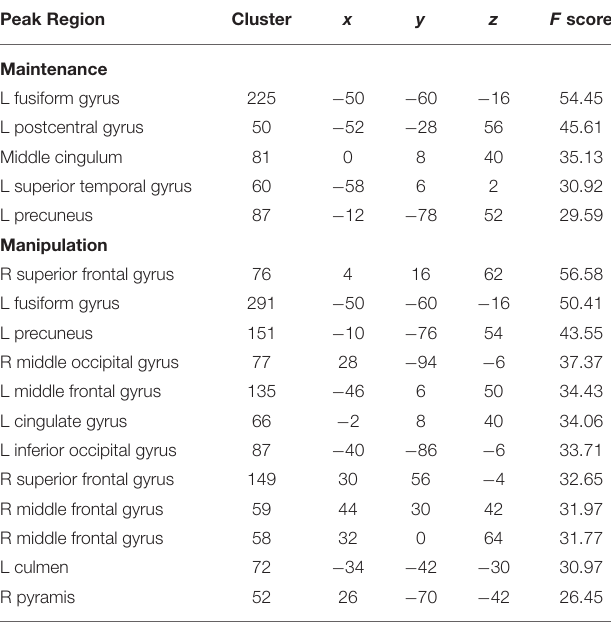
TABLE 3 | Main effect of group difference between MDD patients and HCs (controlling for age, p < 0.05, voxel-wise whole-brain FWE corrected, cluster size >